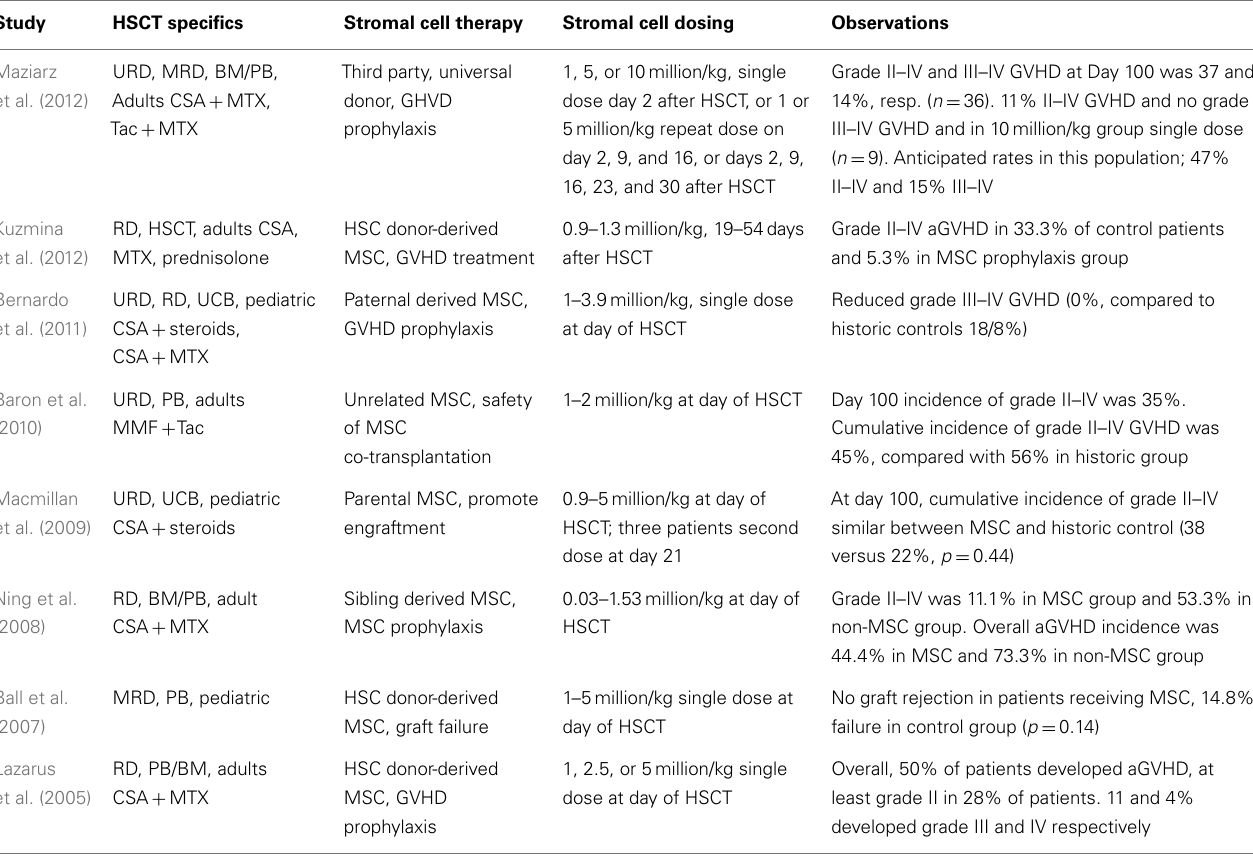
Table 2 | Summary of clinical studies using adherent stem cells for GvHD